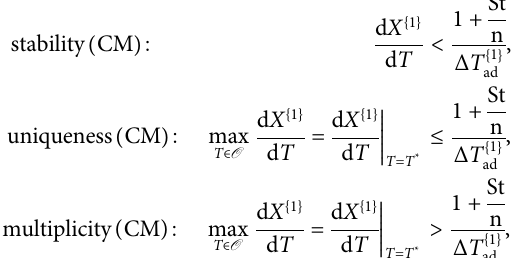
FIGURE 12 | Enumerative solution of operating points (OP) in a multi- stage CSTR cascade with varying residence time, color - OPs of two key stages at the inlet, black - OPs of subordinate branches, reference setting taken from Supplementary Table S1 but T in (cid:2) T cool .